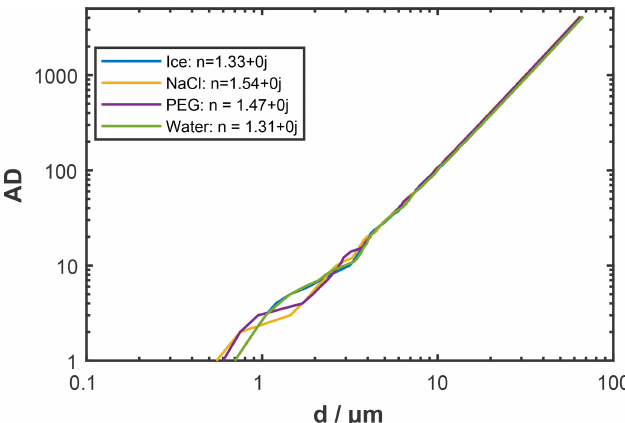
Figure 4. Particle sizing of PPD-HS and APS for spherical (PEG) and aspherical (NaCl) particles, showing the geometric mean of the optical diameter ( d o , g ) determined by PPD-HS as a function of the geometric mean of the aerodynamic diameter ( d a , g ) obtained from the APS, using the calibration setup shown in Fig. 3. Vertical and horizontal error bars indicate the geometric standard deviation of the optical and aerodynamic mean size, respectively. Data points outside the size range of the APS are not shown. A complete list of the individual data sets, including those covering sizes > 20µm, is given in Supplement Table S1.